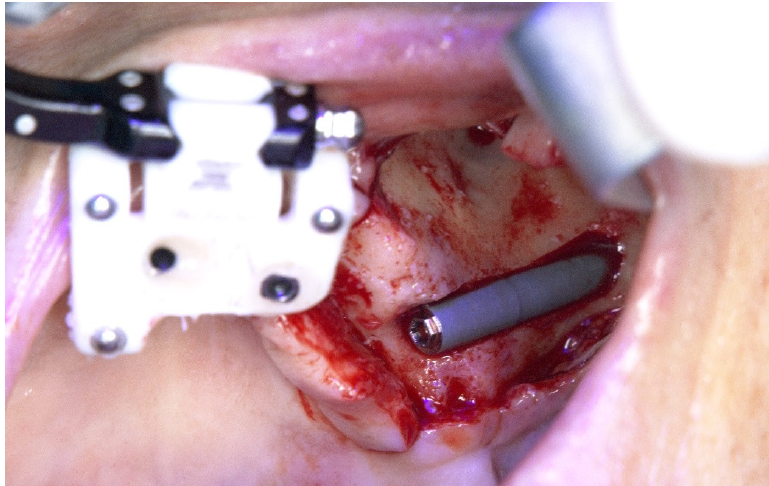
Figure 30. Perioperative photograph after connection of the 45° abutment.